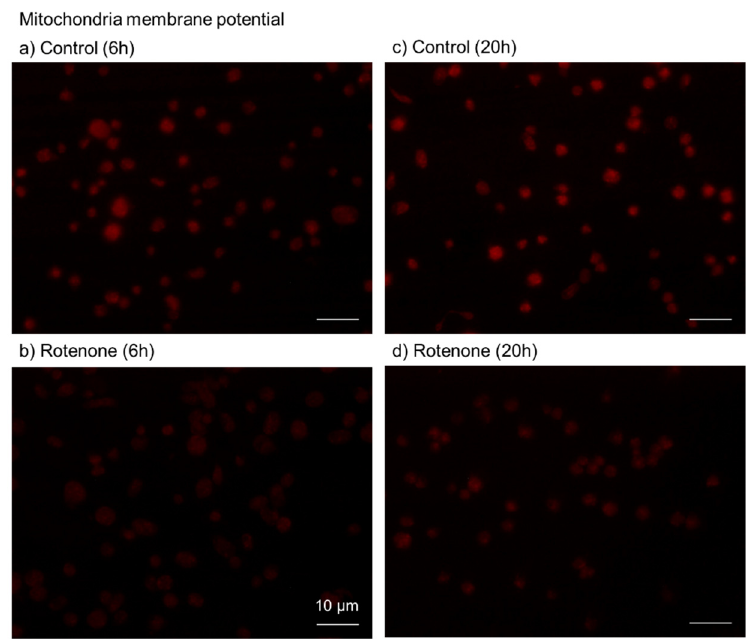
Figure 4. Effects of rotenone on platelet membrane potential. Platelets were treated with 200 μ M